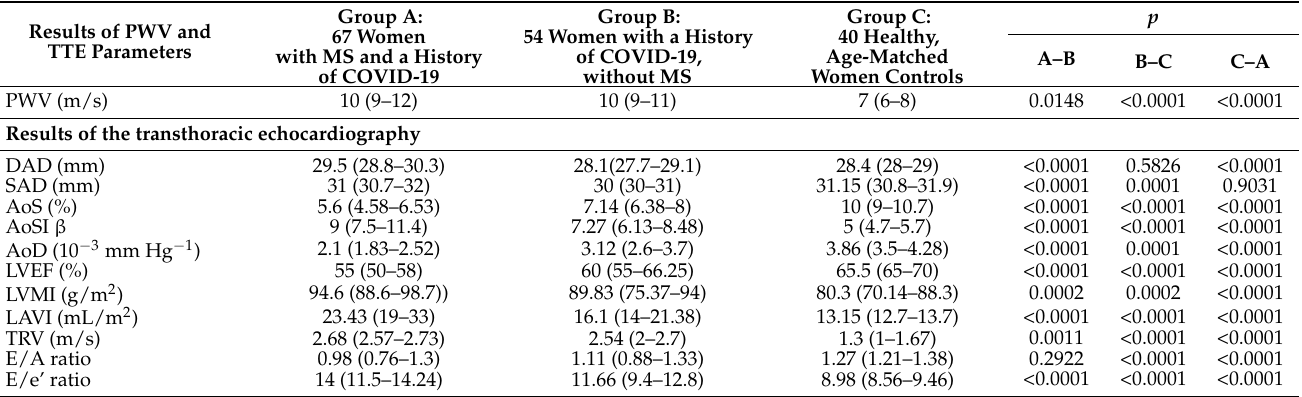
Table 3. Results of the PWV and TTE assessments of the study